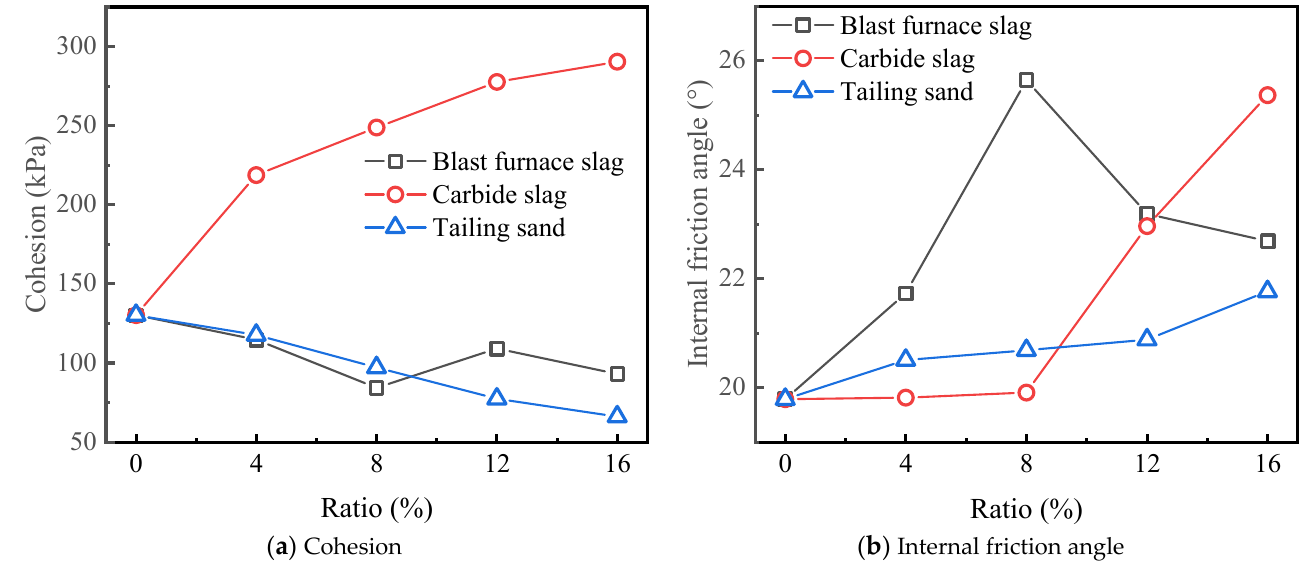
Figure 7. Change curves of cohesion and internal friction angle of different waste residues soils.